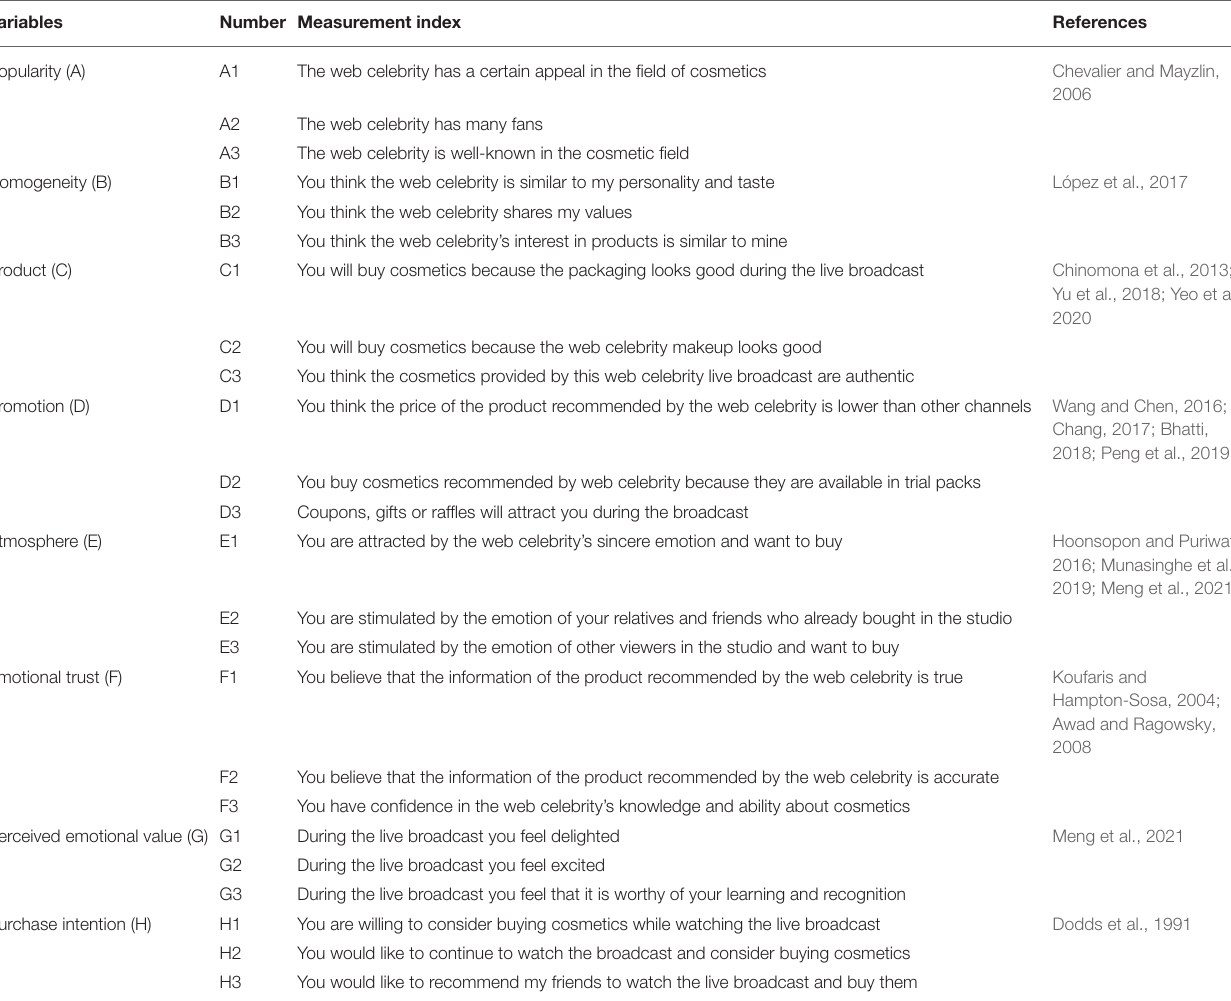
TABLE 1 | Descriptive statistics of key variable indicators.